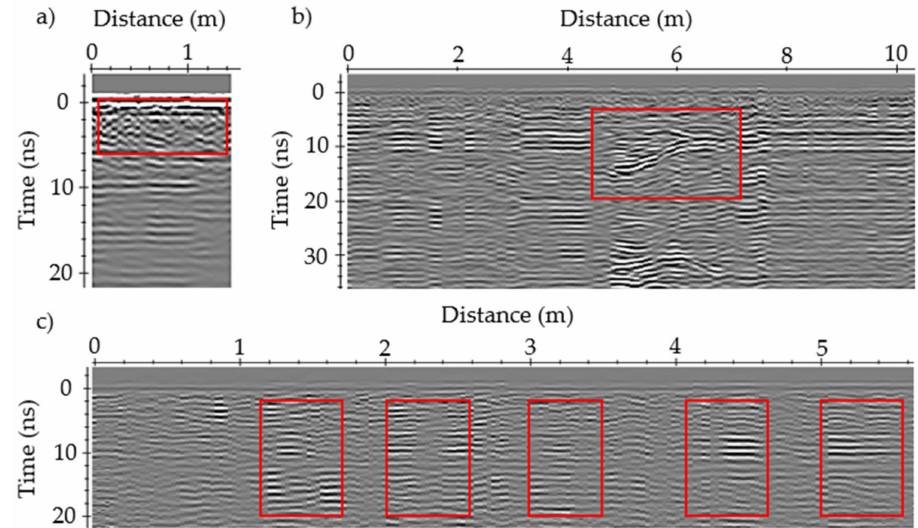
Figure 10. Results obtained from a GPR tunneling inspection: ( a ) shotcrete layer, ( b ) cavity and ( c ) embedded steel arch (adapted from Prego et al.